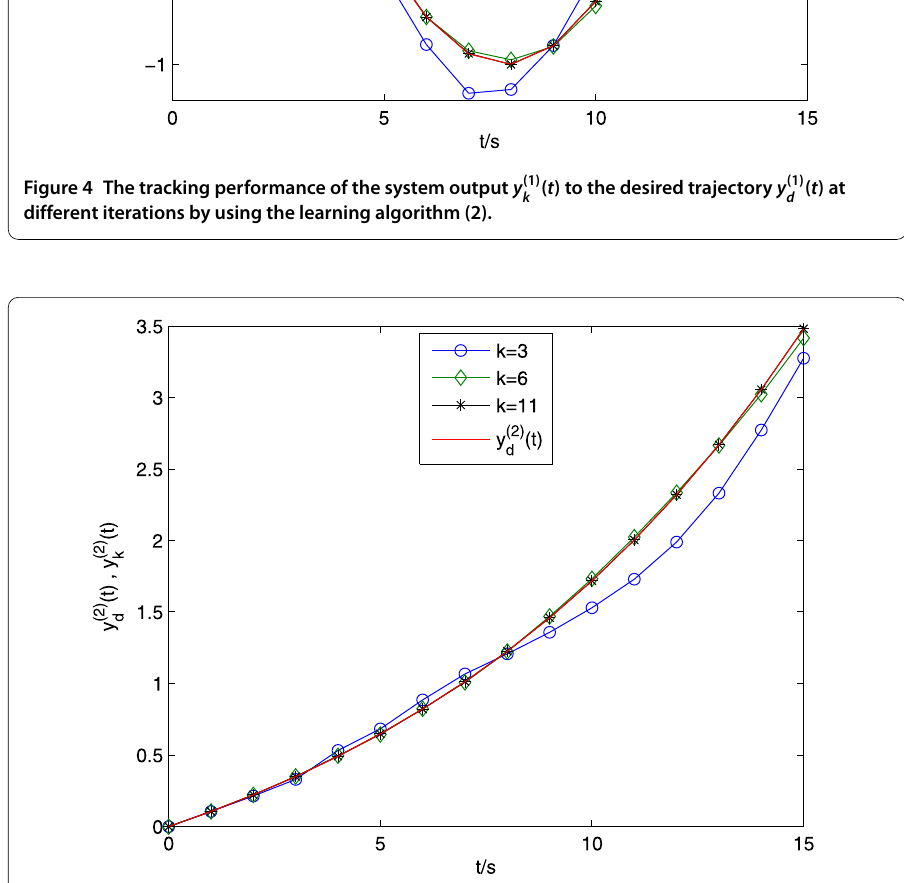
( t ) to desired trajectory y (2) k